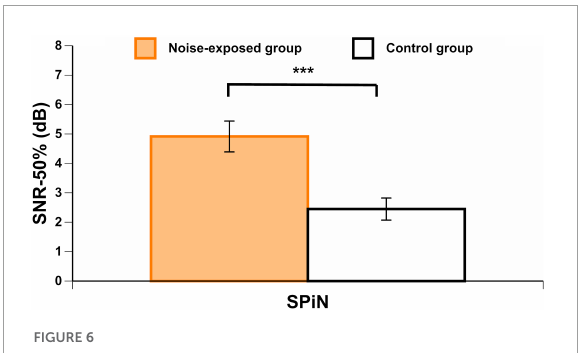
FIGURE6 BKB scores in each group. Higher scores indicate a higher signal-to-noise ratio loss (worse SPiN performance). Error bars represent the standard error. *** p <